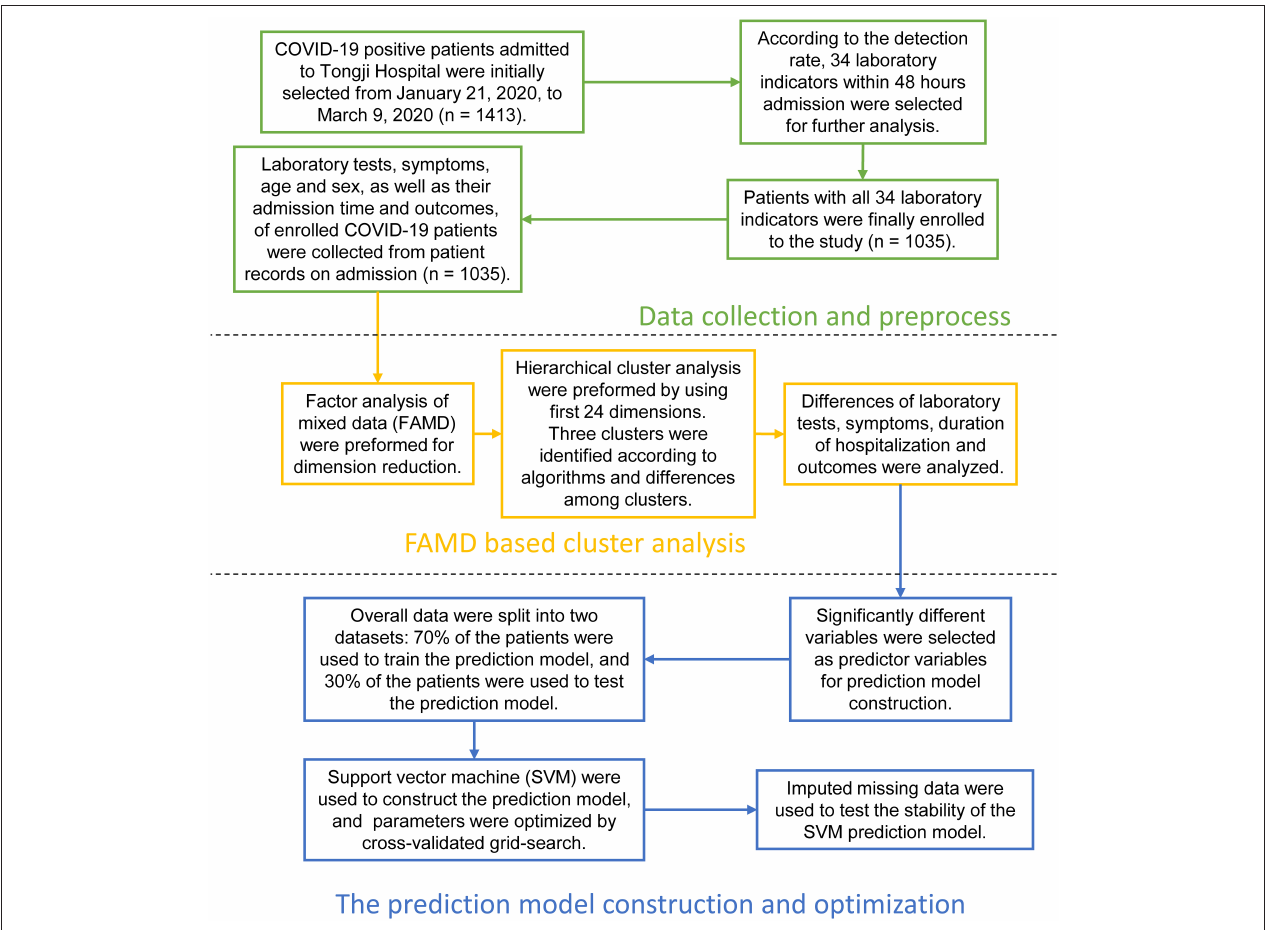
FIGURE 1 | Overall design and analysis process of the study. The study was organized into three parts. First section: Data collection and preprocess. COVID-19 positive patients admitted to Tongji Hospital of Tongji Medical College of Huazhong University of Science and Technology were initially selected from January 21, 2020, to March 9, 2020. Their demographic information, laboratory indicators within 48h admission, medical record-based admission symptoms, as well as duration of hospitalization and outcomes were collected. Afterwards, we investigated the rates of missing laboratory data, and 34 laboratory indicators tested by most patients were identified. Patients with missing 34 laboratory indicators were culled. Laboratory tests, symptoms, duration of hospitalization, and outcomes of 1,035 COVID-19 patients were finally included in the study. Second section: Factor analysis of mixed data (FAMD) based cluster analysis. We used FAMD as the dimensionality reduction method, and first 24 dimensions were selected and retained for further unsupervised cluster analysis. Three major clusters were identified according to algorithms and differences among clusters. We compared the differences in laboratory tests, symptoms, duration of hospitalization, and outcomes among the three clusters in detail. Third section: Prediction model construction and optimization. We constructed a COVID-19 support vector machine (SVM) classifier according to the results of the unsupervised clustering in this section. Firstly, overall data was randomly divided into 70% training and 30% test dataset. The optimal parameters were found by using the grid search based on 10-fold cross validation on 70% training dataset, and the classification performance of the model were tested by testing 30% dataset. Secondly, all patients were randomly divided into 50% training and 50% missing test dataset. About 1–10% laboratory data in the missing dataset were removed randomly, and missing data were imputed by k -nearest neighbor (KNN) method. The SVM model was trained by 50% training dataset, and missing test dataset was used to test the performance of the SVM model in the case of missing